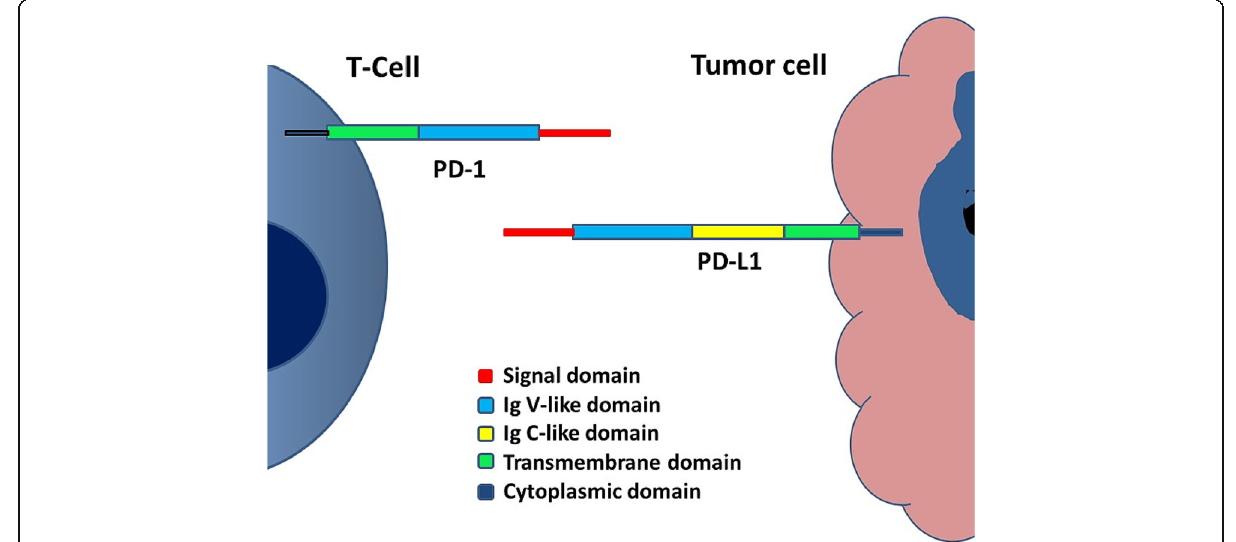
Fig. 4 Cartoon revealing the structure of PD-L1 on the tumor cell and PD-1 expressed on the surface of